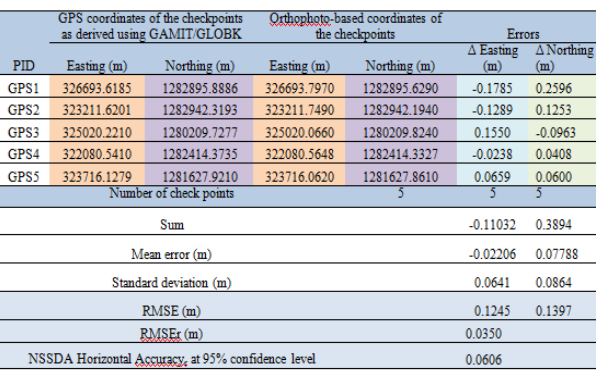
Table 2. Comparison between GPS coordinates and